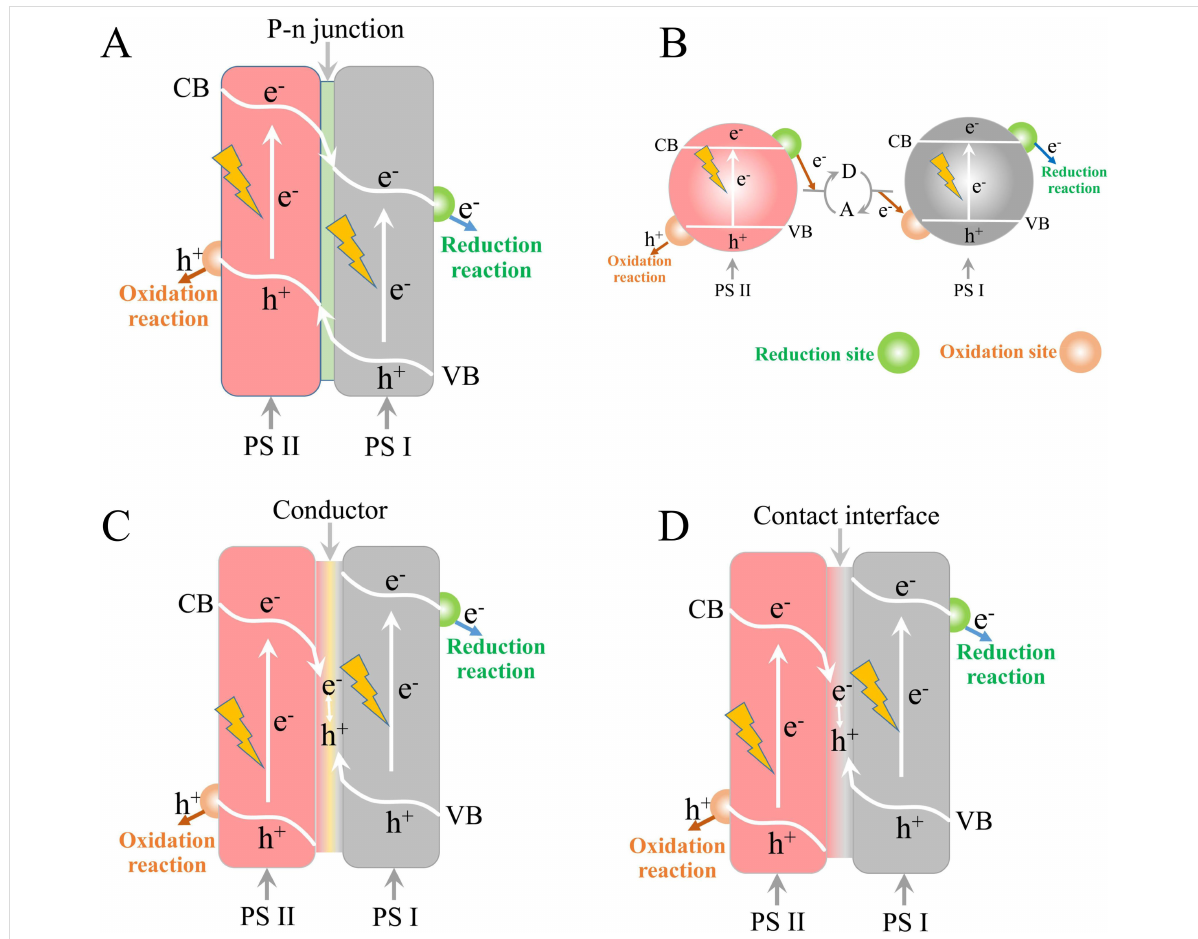
Figure 3: Schematic diagrams of heterojunction and Z-scheme systems. Transfer of charge carriers in (A) the heterojunction-type photocatalytic system, (B) the Z-scheme PS-A/D-PS system, (C) the Z-scheme PS-C-PS system, and (D) the Z-scheme electron PS-PS system. Adapted from [68], copyright 2014 Wiley-VCH Verlag GmbH & Co. KGaA. PS stands for